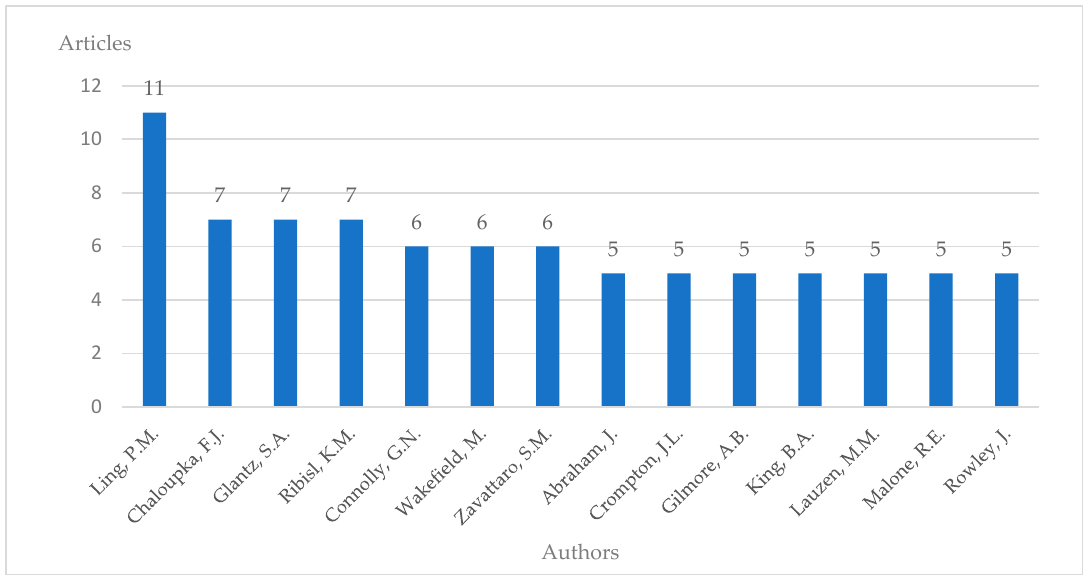
Figure 4. Authors with most articles published in the sample.